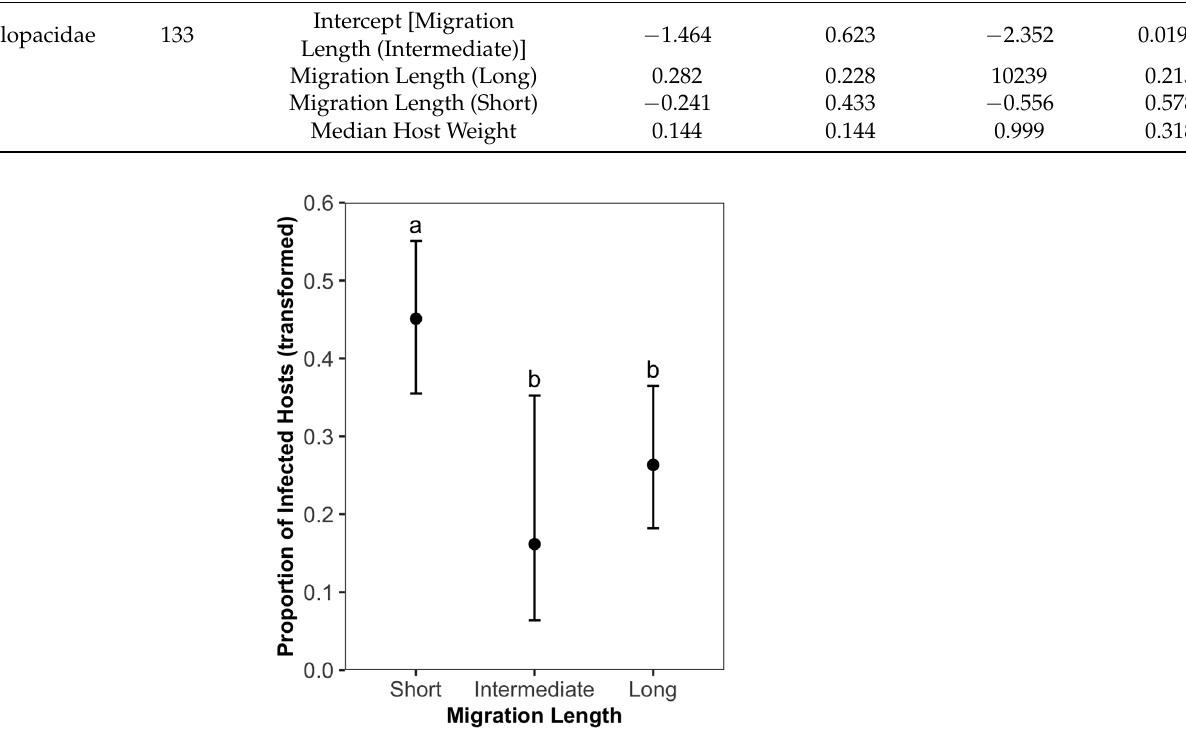
Figure 1. Comparison of prevalence of Saemundssonia lice between hosts that migrate different lengths. Letters indicate results from pairwise comparisons and denote significant differences be- tween groups.